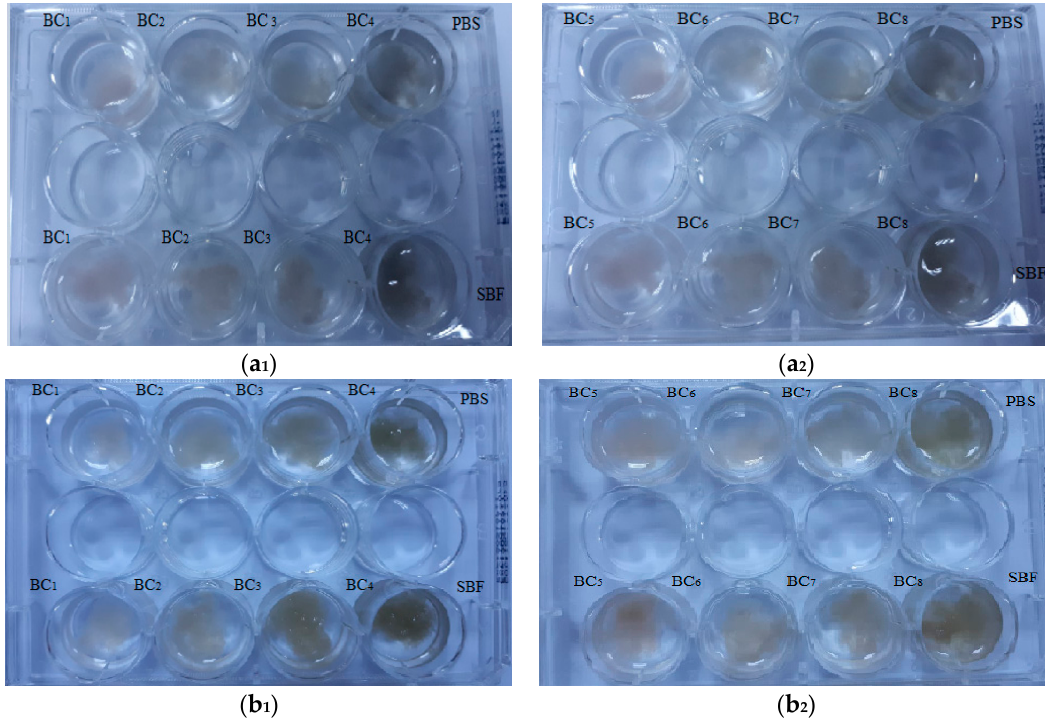
Figure 11. Macroscopic pictures of degradation of BC composites initially ( a 1 , a 2 ) and after seven days of immersion in phosphate-buffered saline (PBS) and simulated body fluid (SBF) ( b 1 , b 2 ).